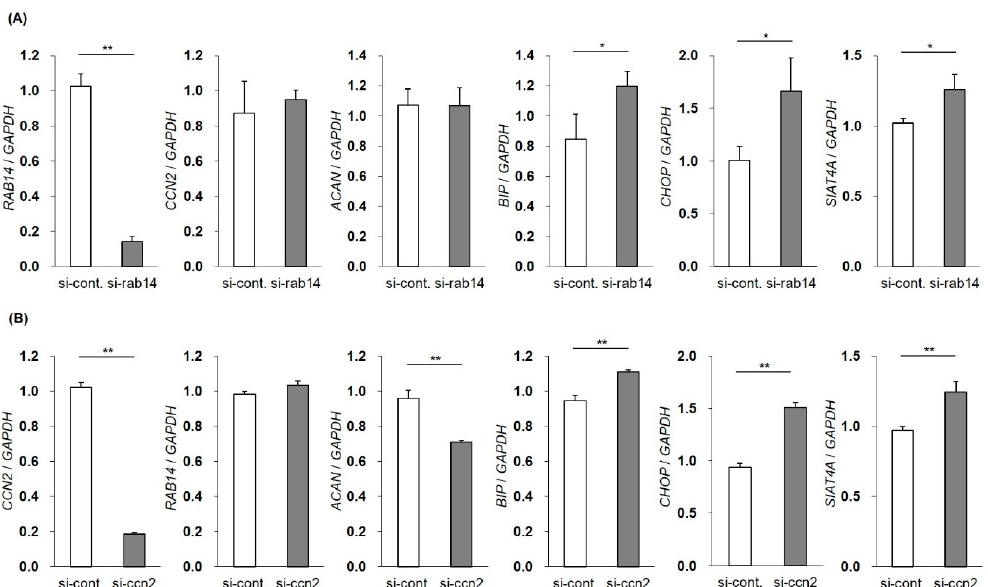
Figure 4. Changes in the gene expression by the silencing of the RAB14 or CCN2 gene. The expression of RAB14 or CCN2 mRNA was reduced using siRNA in HCS-2/8 cells, and the gene expression of RAB14 , CCN2 , ACAN , BIP , CHOP and SIAT4A mRNA was monitored by qRT-PCR. The mRNA expression profile of CCN2 , ACAN, and stress marker genes in RAB14 knockdown cells ( A ). The mRNA expression profile of RAB14 , ACAN, and stress marker genes in CCN2 knockdown cells ( B ). The level of each mRNA was standardized to that of GAPDH mRNA. The data are presented as the mean ± SD of triplicate samples ( t -test * P < 0.05, ** P < 0.01).